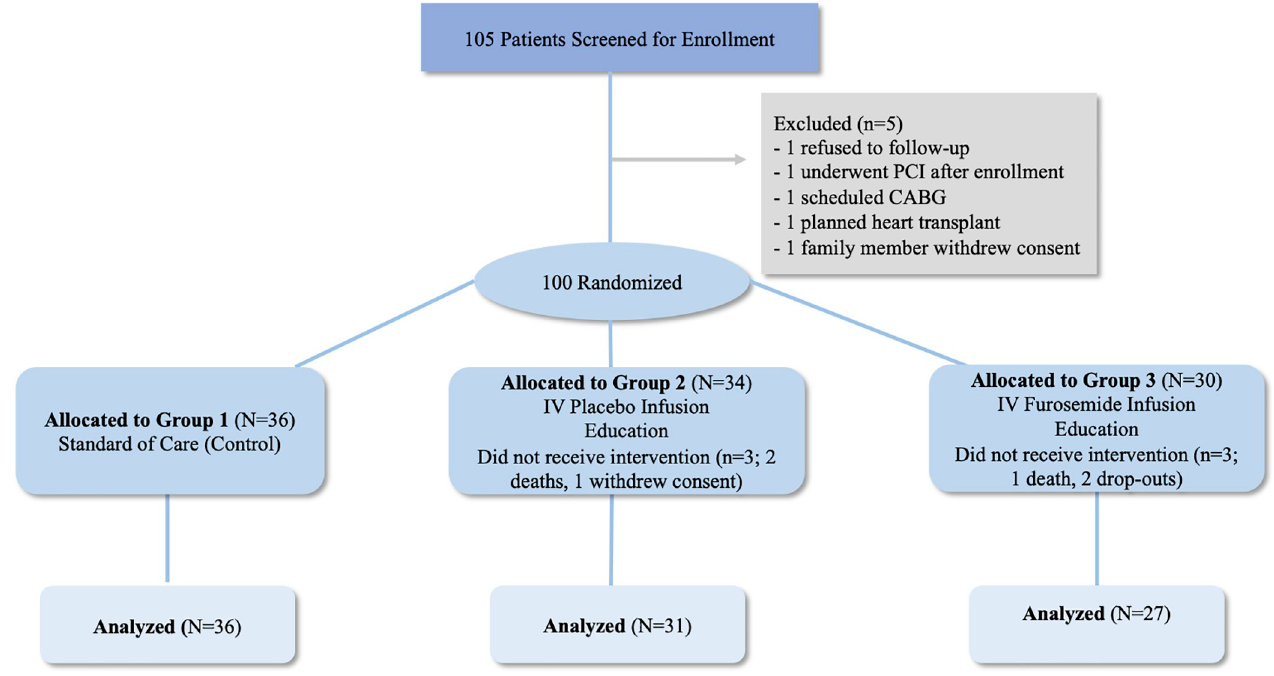
Fig 1. Overall study flow diagram. CABG, coronary artery bypass graft; IV, intravenous; PCI, percutaneous coronary intervention.